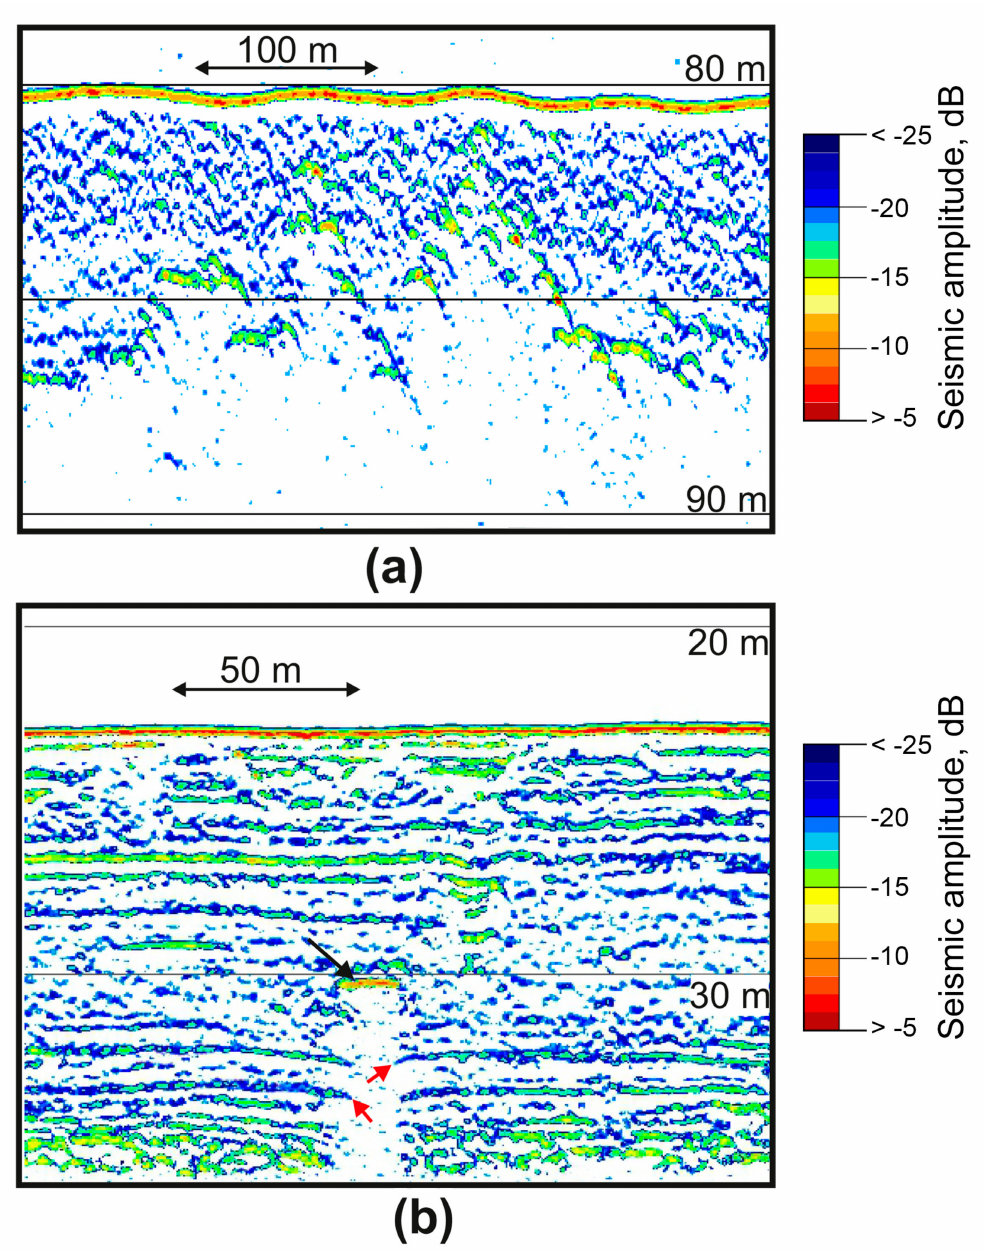
Figure 11. Fragments of seismic sections with signs of anomalous gas saturation of sediments based on SES-2000 data obtained in the Laptev Sea: the appearance of many diffracted waves ( a ), enhanced reflection amplitudes (black arrow) and pull-down reflectors (red arrows) ( b